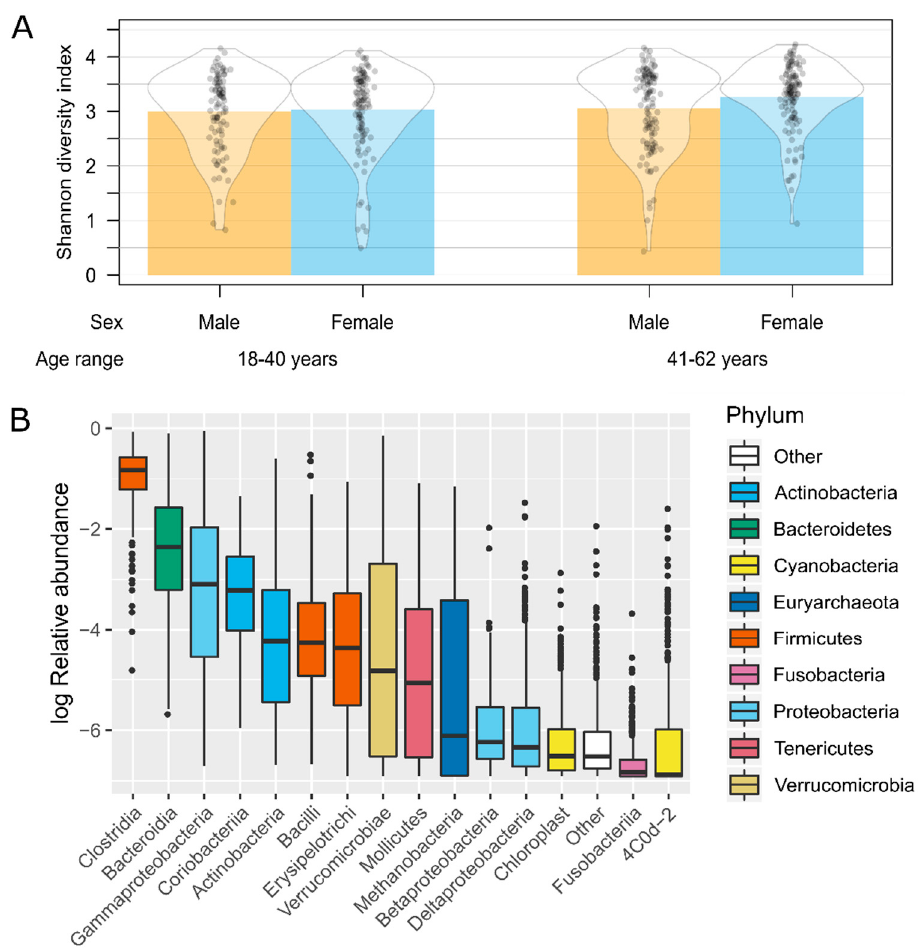
Figure 2. Gut microbiota diversity and composition of the studied population. ( A ) Distribution of alpha diversity (Shannon diversity index) by sex and age group. ( B ) Taxonomic profile at the class level. Classes with a median relative abundance equal to zero were combined into “Other”. The color code corresponds to the taxonomic classification at the phylum level.